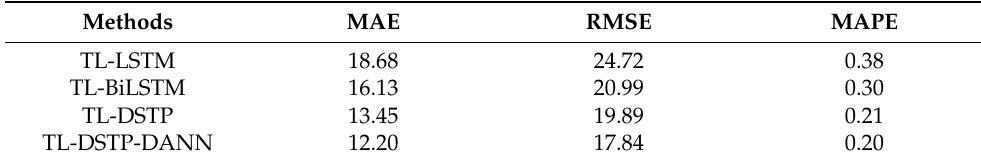
Table 4. Performance of different models in predicting PM2.5 concentrations in Guangzhou.